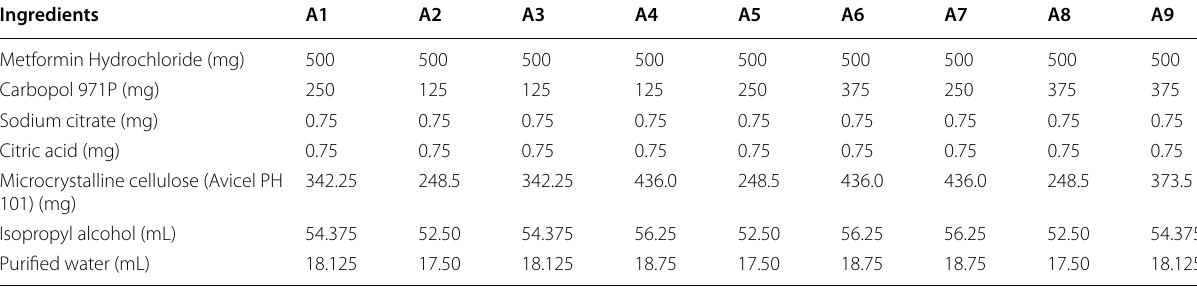
Table 1 Composition of different formulations of MFH pellets Ingredients